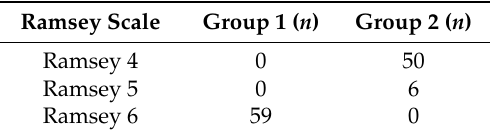
Table 3. Ramsey sedation scores in the studied groups.